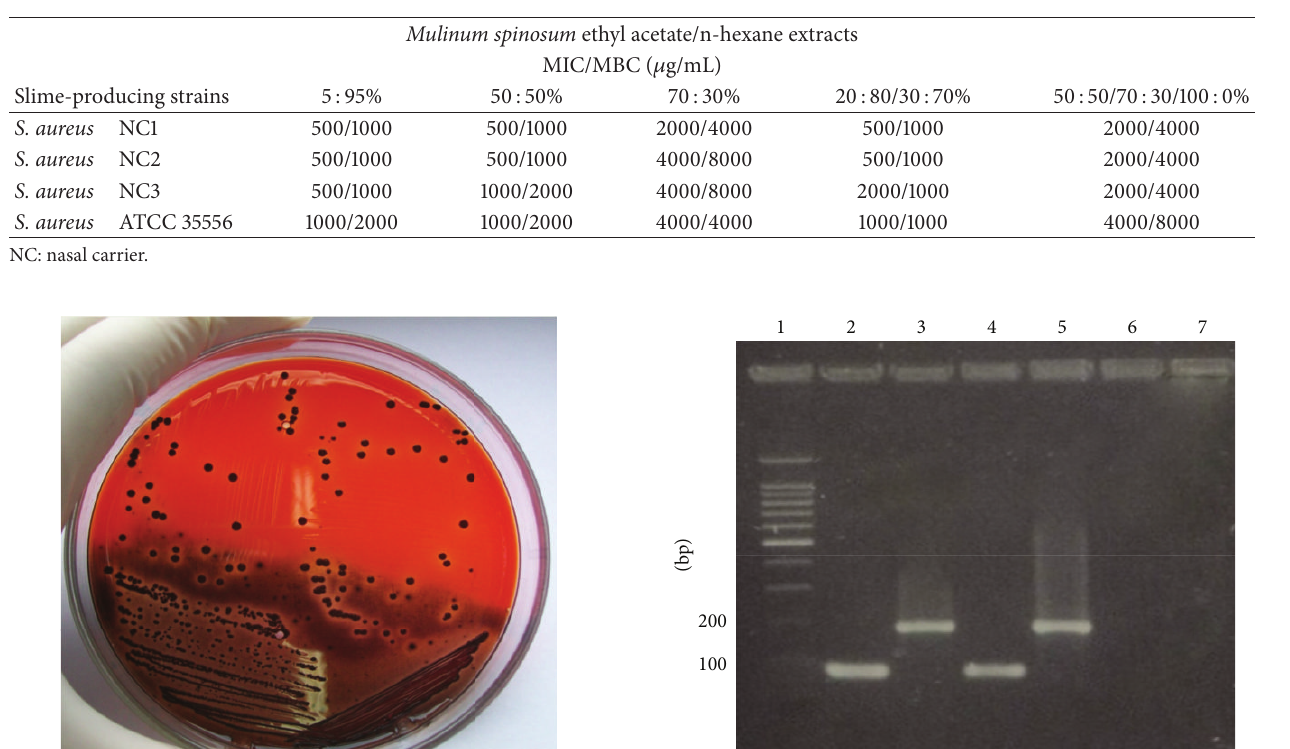
Table1:Minimalinhibitoryconcentrationandminimalbactericidalconcentrationof M.spinosum extractsagainstslime-producing S.aureus .